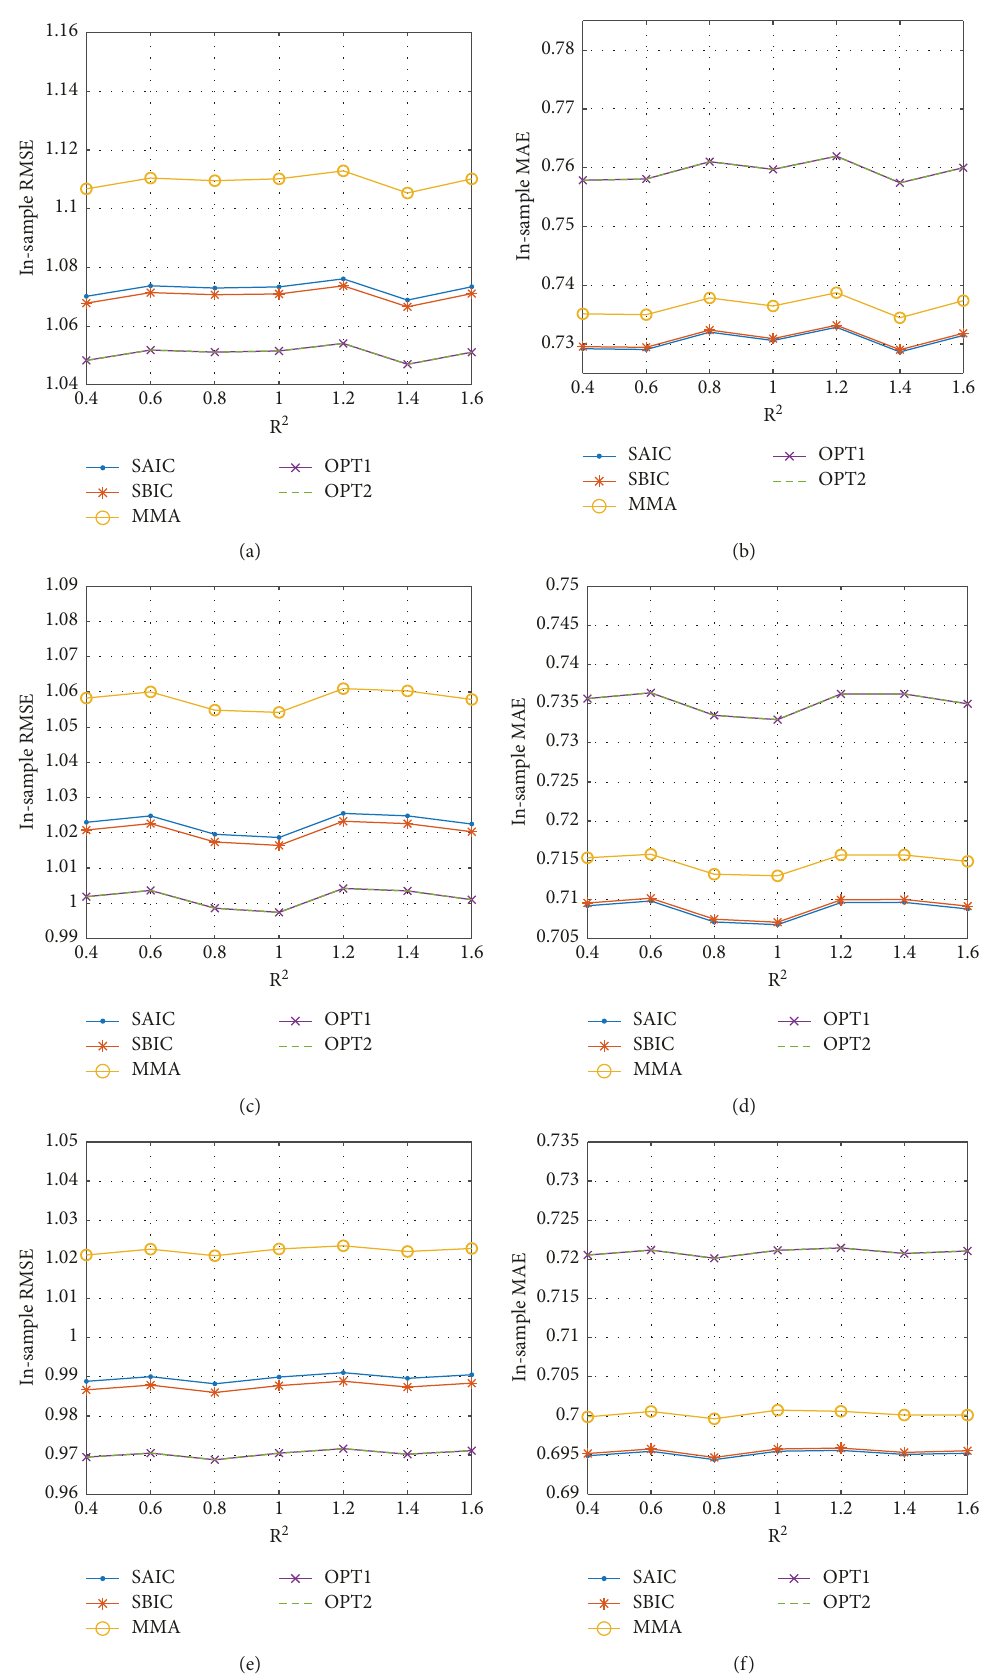
Figure 1: In-sample fitting results with different R 2 for simulation 1. (a) n � 1000. (b) n � 1000. (c) n � 2000. (d) n � 2000. (e) n � 5000. (f) n �